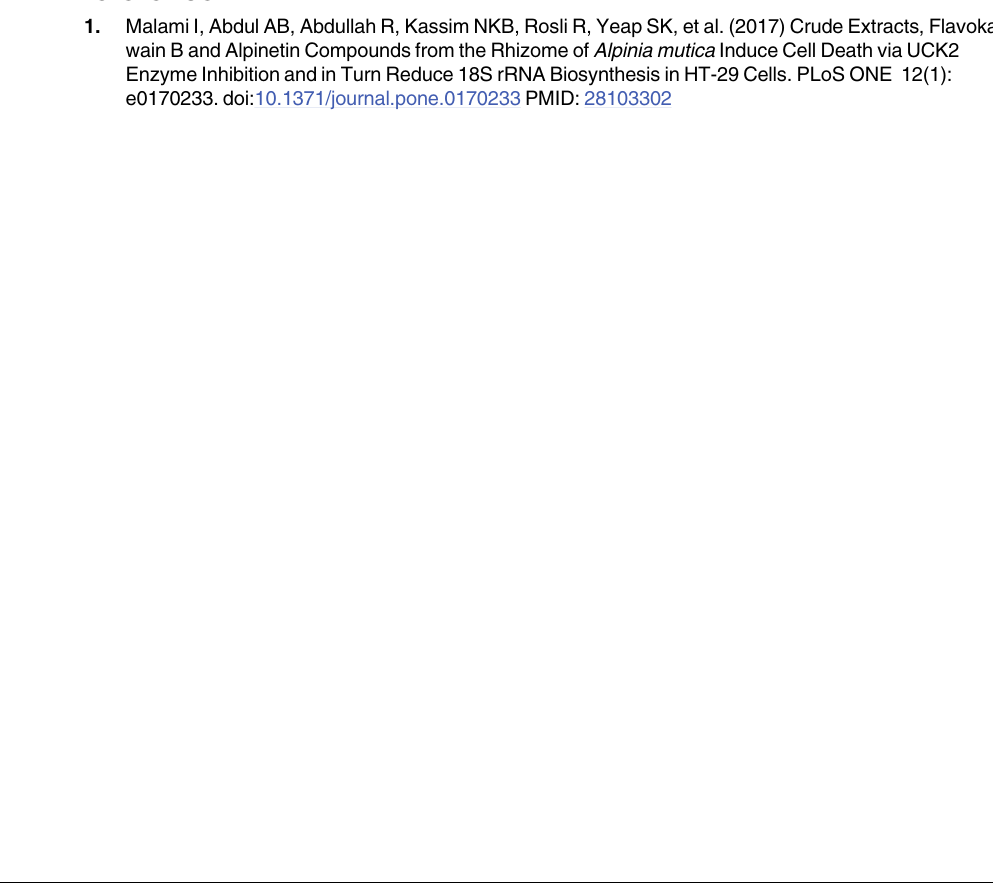
Enzyme Inhibitionand in Turn Reduce18S rRNA Biosynthesis in HT-29 Cells. PLoS ONE 12(1): e0170233.doi:10.1371/journal.pone.0170233 PMID: 28103302